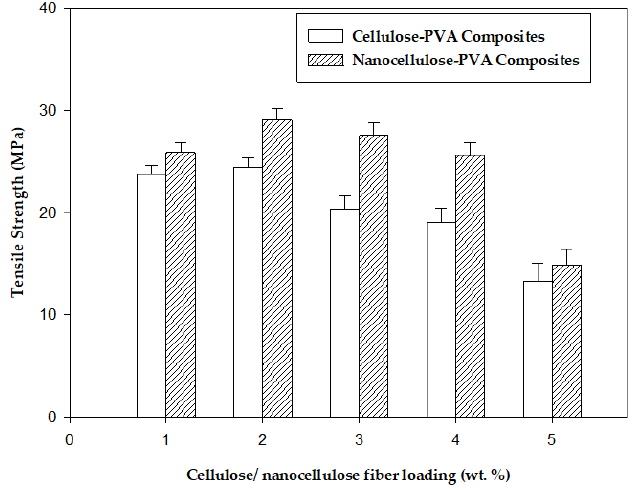
Figure 5. Tensile strength (MPa) vs. cellulose / nanocellulose fiber loading (wt.%) of cellulose / nanocellulose cellulose/nanocellulose reinforces PVA composites. reinforces PVA composites. cellulose/nanocellulose reinforces PVA composites.